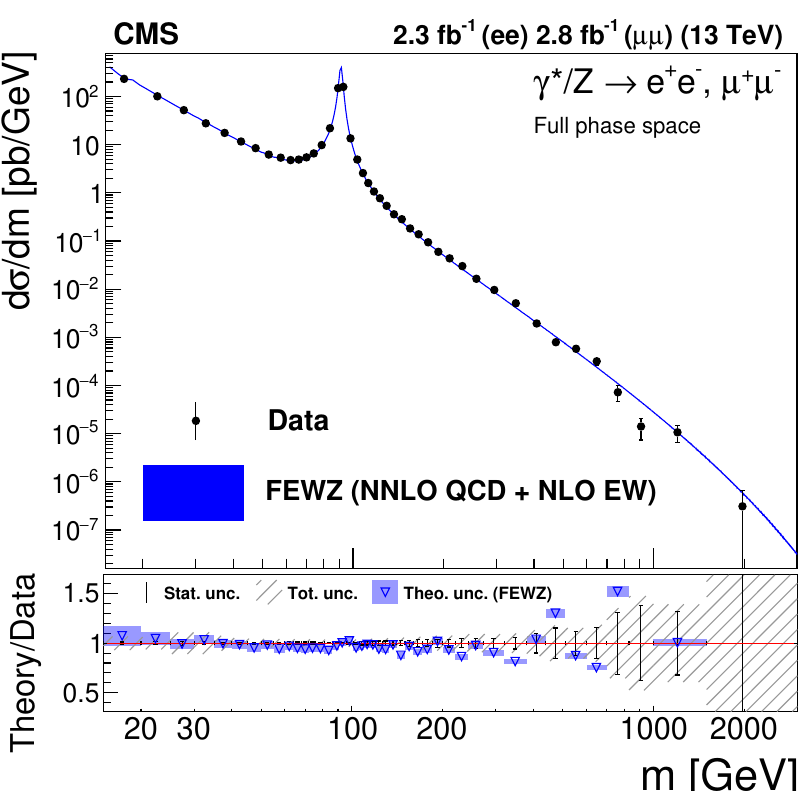
Figure 6 . The di(cid:11)erential DY cross section measured for the combination of the two channels and as predicted by the NNLO theoretical calculation of fewz with NNPDF 3.0 in the full phase space. The ratio between the data and the theoretical prediction is presented in the bottom panel. The coloured boxes represent the theoretical